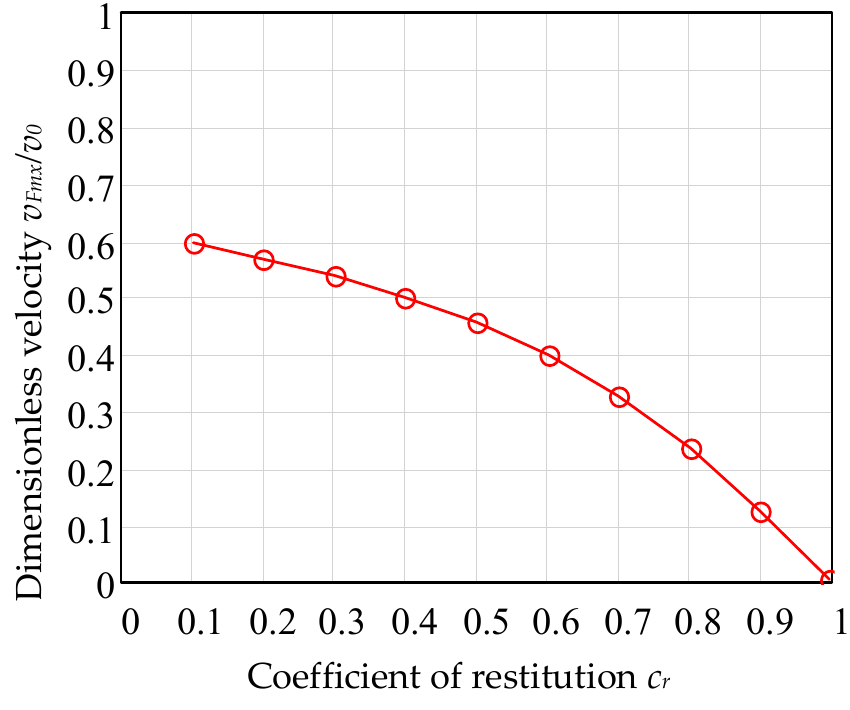
Figure 29. Dependency of velocity corresponding to maximum force ( v Fmx ) on coefficient of restitution ( c r ) .